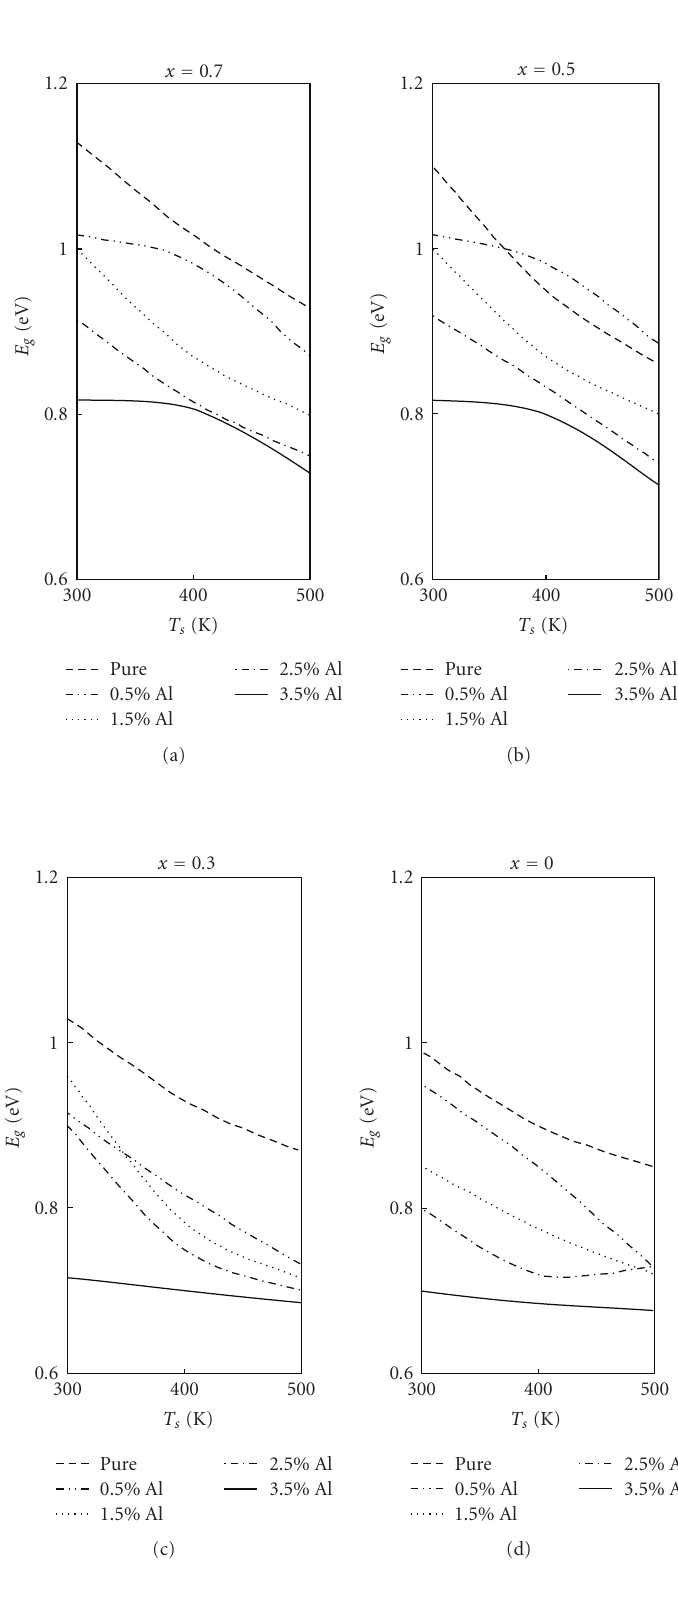
Figure 3: Variation of E g as a function of T s for films deposited with di ff erent values x in pure and doped a-Ge x Si 1 − x :H thin films with various percentage of